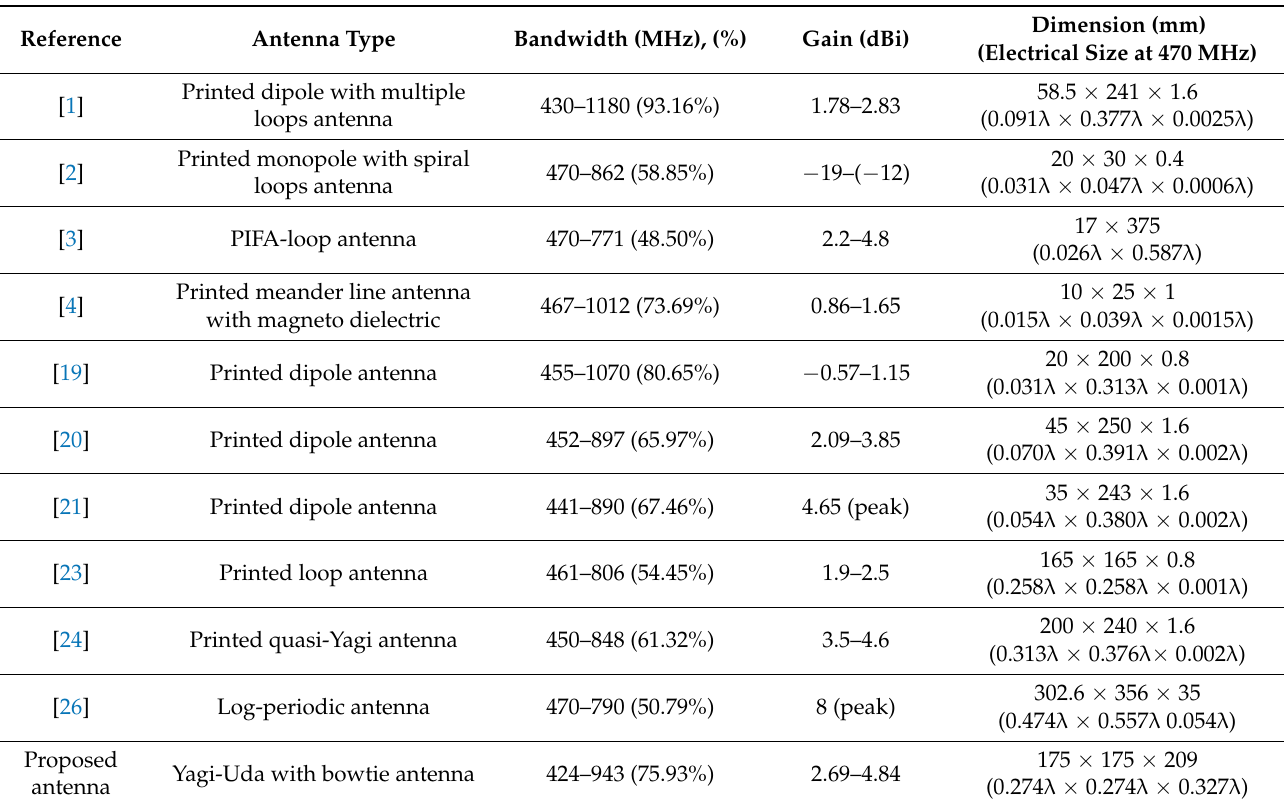
Table 3. Comparison between previous works and the proposed portable wideband directional antenna